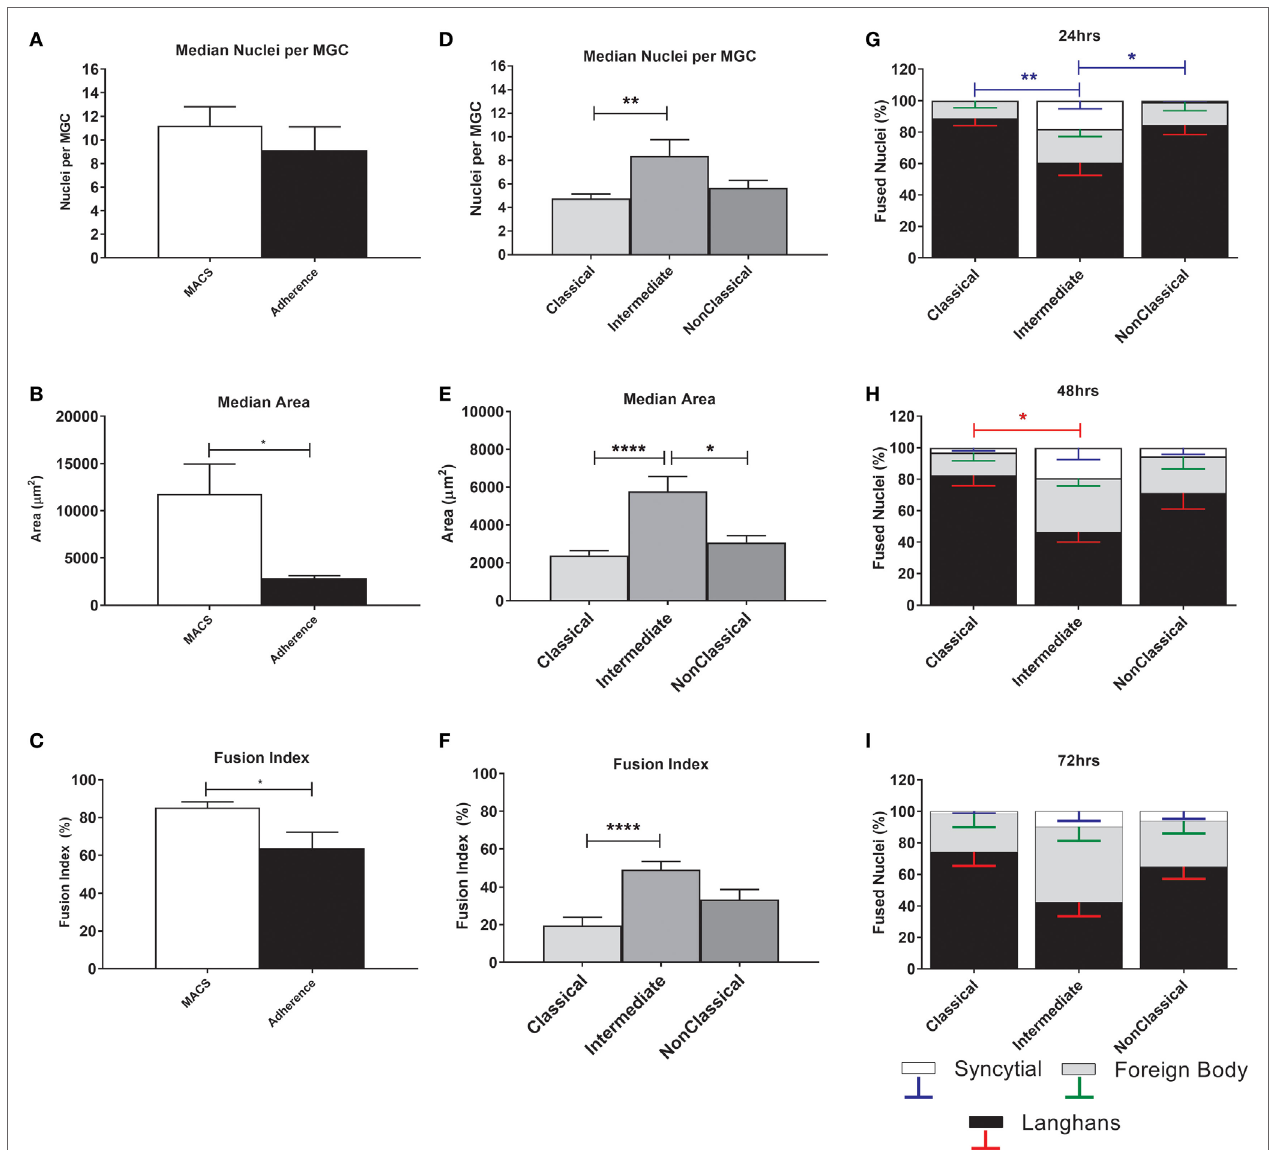
FigUre 3 | Fusion parameters vary between monocyte purification method and between subsets. (a–c) Unfractionated monocytes, purified by magnet­activated cell sorting (MACS) or adherence were incubated for 72 h with concanavalin A (ConA) to induce fusion. After fluorescence imaging, three parameters of monocyte­ derived giant cell (MGC) were recorded: median number of nuclei/MGC, fusion index (FI), and median area occupied by each MGC. Significance was tested using an unpaired t ­test. (D–F) Monocytes sorted into subsets by FACS were incubated for 72 h with ConA to induce fusion. After fluorescence imaging, three parameters of MGC were recorded: median number of nuclei/MGC, FI and median area occupied by each MGC. Significance was tested with a Kruskal–Wallis test with a Dunn’s multiple comparisons test. (g–i) After 24, 48, and 72 h incubation with ConA, the proportions of each type of MGC were recorded and presented as a percentage of the total fused nuclei counted. Bars represent means ± SEM, n = 8. Significance was tested with a Kruskal–Wallis test with a Dunn’ multiple comparisons test comparing the means of the same MGC type within the same time point against the other subset means. Black bars/red error bars: Langhans giant cell, gray bars/green error bars: FBGC and white bars/blue error bars: syncitial giant cell